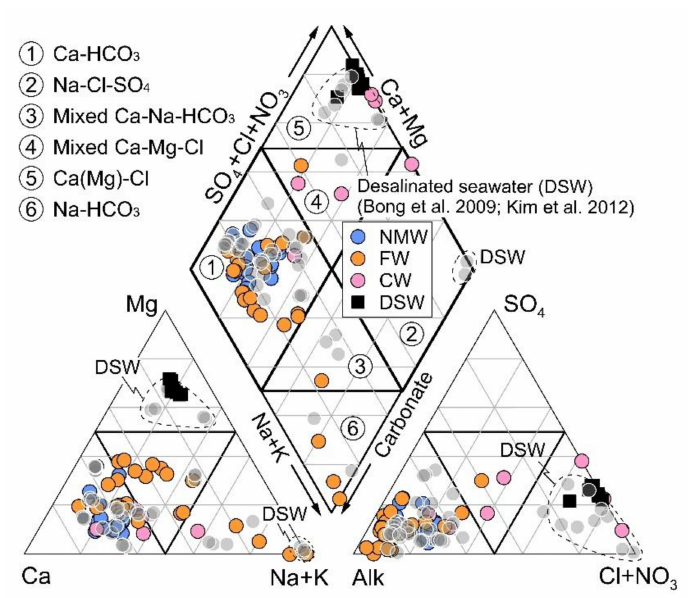
Figure 3. Piper diagram including four types of Korean bottled waters along with previous studies